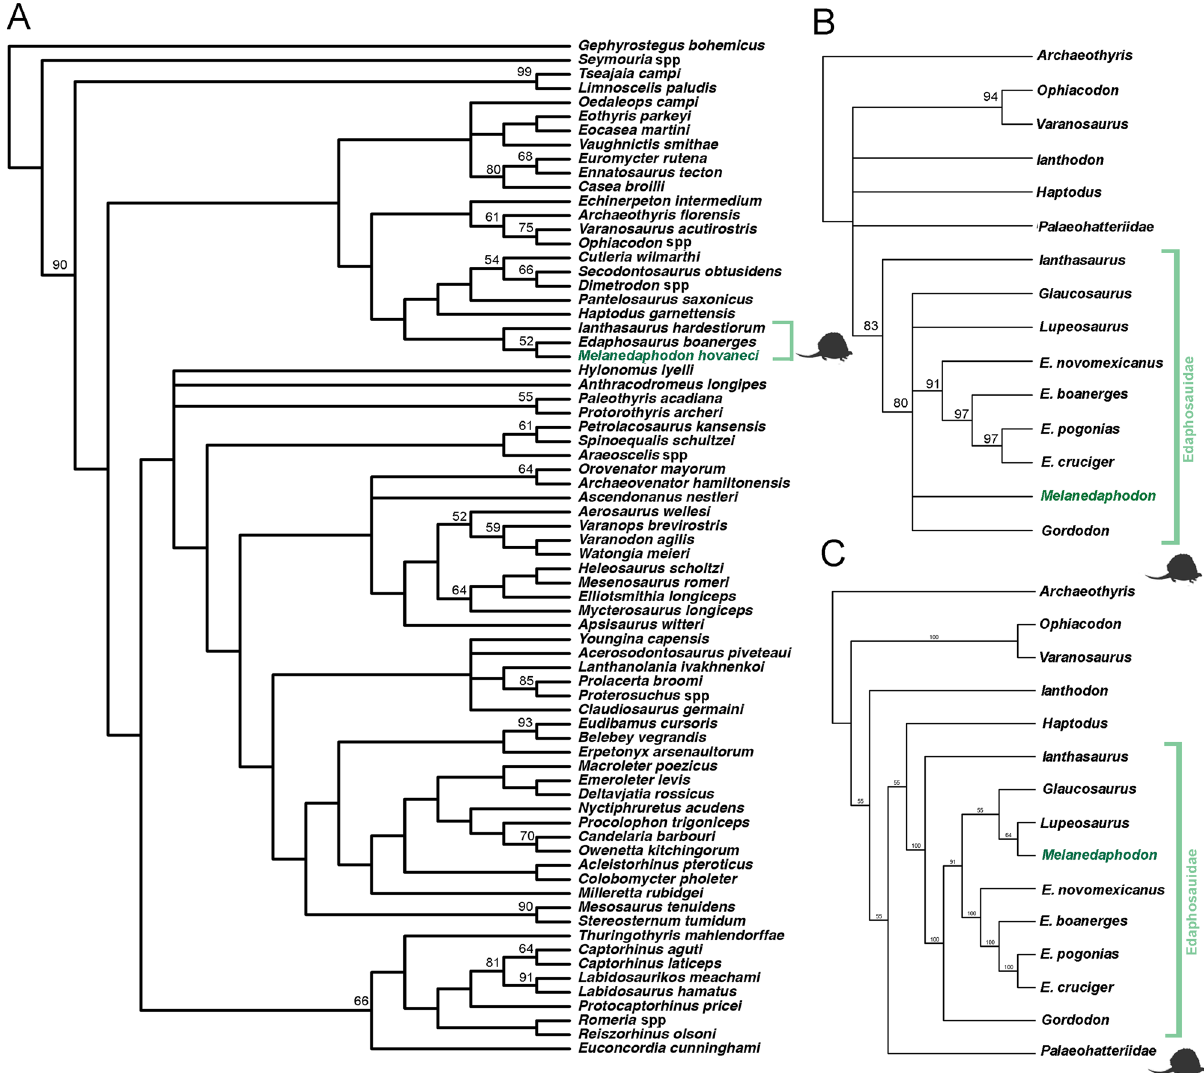
Figure 4. ( A ) Strict consensus of the results of the parsimony analysis of early amniotes based on Ford and Benson 29 . ( B ) Strict consensus of the results of the parsimony analysis of Edaphosauridae based on Spindler et al. 20 . ( C ) Majority-rule consensus of the results of the parsimony analysis of Edaphosauridae based on Spindler et al. 20 . In all analyses, Edaphosauridae is demarcated by a light green bracket and Melanedaphedon hovaneci gen. et sp. nov. is highlighted in dark green. In the strict consensus trees, bootstrap values greater than 50% are indicated above Edaphosauridae. For this analysis, in addition to our new taxon, we also added the recently described Gordodon 27 as well as limited our OTU sample to taxa that were reasonably well-diagnosed and not solely based on highly fragmentary postcranial material. In both analyses Melanedaphodon was coded as a composite of both specimens to achieve the most complete character sampling. For the first analysis, using the matrix of Ford and Benson 29 , we conducted a parsimony analysis using PAUP software v4.0b10 30 with Gephyrostegus designated as the outgroup. The heuristic search option was selected, with Maxtrees set at 10,000 and set to automatically increased by 100. All characters were treated as equally weighted, and multistate taxa were treated as polymorphic. Ambiguous character states were resolved using the ACC TRA N setting. Indices of goodness of fit of the character data to the topology (e.g., consistency index [CI], homoplasy index [HI]), retention index [RI], rescaled consistency index [RC]) were calculated in PAUP. To assess support of internal nodes, bootstrap values were calculated using the “fast” stepwise addition option. The parsimony analysis recovered 18 most parsimonious trees (MPT), each with 1619 steps (CI = 0.255; HI = 0.772; RI = 0.593; RC = 0.151). The strict consensus of the results recovered Melanedaphodon as an edaphosaurid synapsid, specifi- cally as sister taxon to Edaphosaurus to the exclusion of Ianthosaurus (Fig. 4A). The topology otherwise remain consistent to what is reported in Ford and Benson 29 .